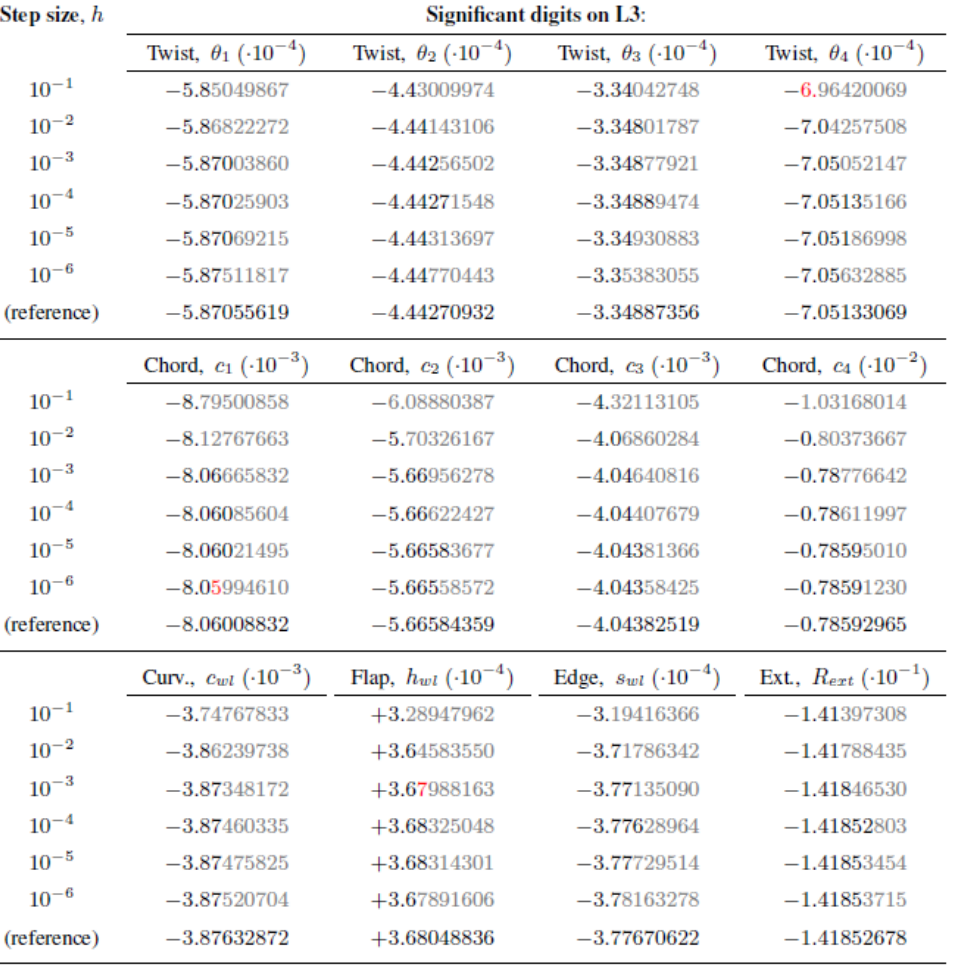
Table 4. Table showing how the finite difference gradient accuracy depends on the chosen step size. The machine-accurate reference gradient is computed with the Complex-Step